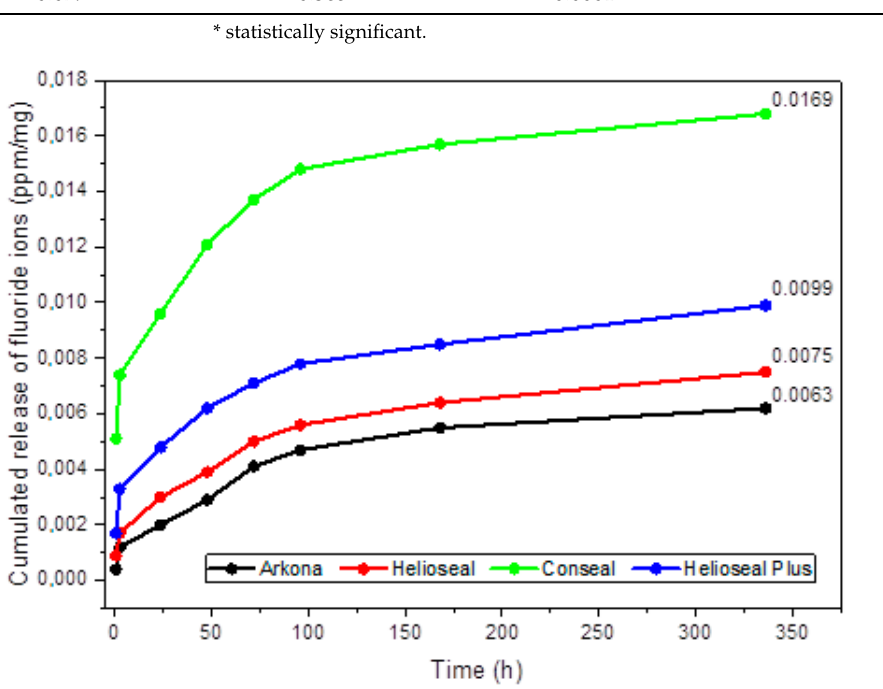
Figure 4. Cumulative fluoride ion release (ppm/mg) from fissure sealants into 0.9% NaCl. Dots represent the means of measurements.